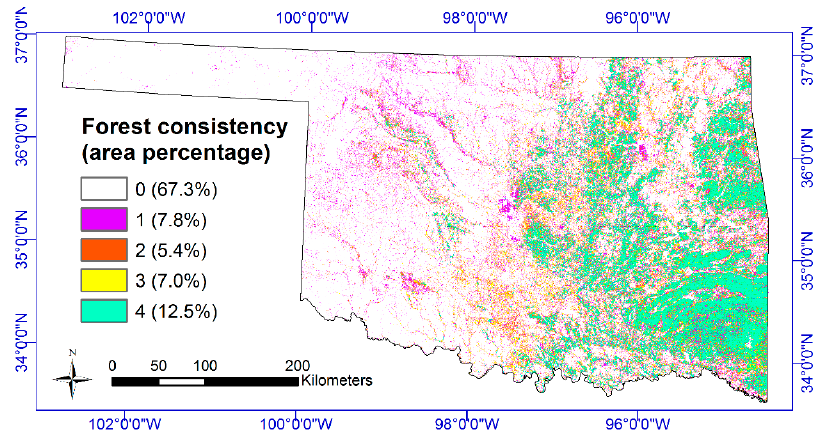
Figure 7. The spatial distribution map of the forest frequency in Oklahoma in 2010. The input forest maps were from the PALSAR/Landsat forest map, JAXA forest map, NLCD2011, and OKESM, respectively.